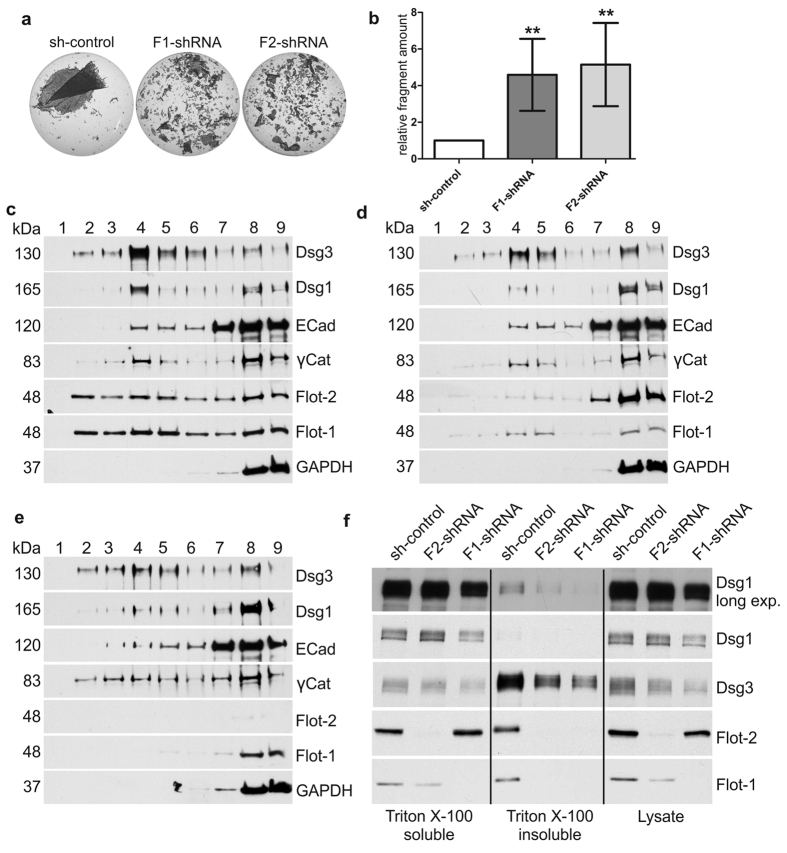
Flotillin knockdown weakens the adhesion strength in HaCaT keratinocytes but does not affect the raft association or detergent solubility of Dsg1 and Dsg3.(a) HaCaT cells depleted of flotillin-1 (F1-shRNA) and flotillin-2 (F2-shRNA) and control shRNA cells (sh-control) were dissociated from the plate with dispase and the monolayers were mechanically disrupted. Fragments were fixed, stained and imaged. (b) Relative fragment number from six independent experiments. Bars represent the mean ± SD. One-way ANOVA with Bonferroni’s multiple comparison test. *p < 0,05, **p < 0,01, ***p < 0.001. (c–e) Rafts were isolated from control shRNA (c) and flotillin-1 (d) or flotillin-2 (e) depleted HaCaT cells using detergent extraction and density gradient centrifugation. Nine fractions were collected from the top of the gradient (fraction 1 = the lightest fraction) to the bottom and analysed by Western blot. (f) Sequential detergent extraction of HaCaT control and flotillin knockdown cells. Cells were initially extracted with a Triton X-100 buffer followed by solubilisation of the Triton X-100 insoluble proteins with an SDS/urea buffer. Equal volumes of extracted proteins were analysed by Western blot. Please note that the total volume of the insoluble pool is twice that of the soluble one. The lysates shown in the last three rows were extracted with a NP-40 containing lysis buffer to facilitate solubilisation. The quantifications for (c–f) are shown in Supplementary Figure S3.